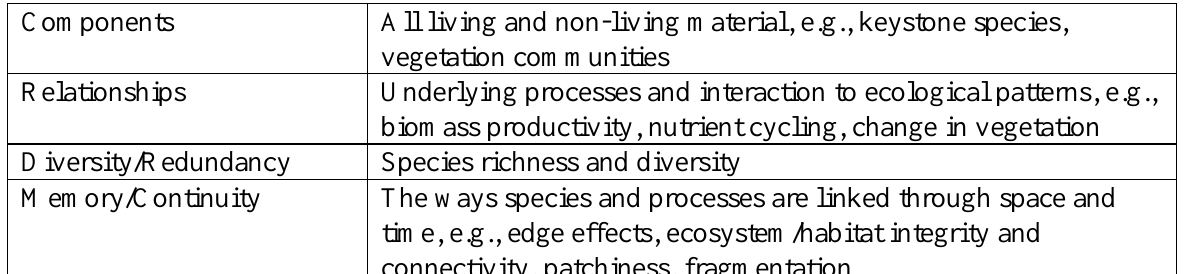
Table 1.3. Description of parameters used to code ecological outcomes in the review (adapted from Plummer and Armitage,